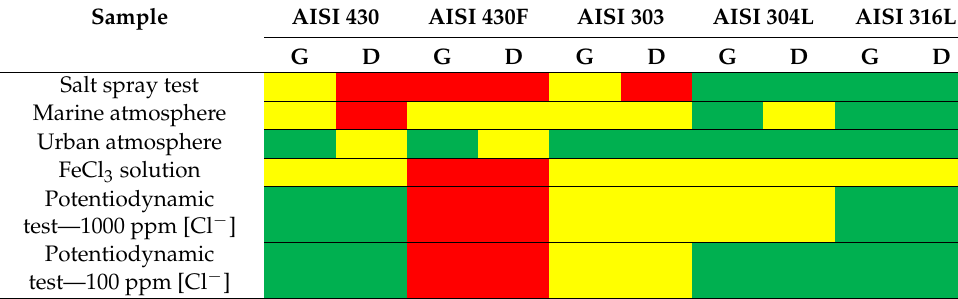
Table 9. Localized corrosion resistance results: G = ground and D = drawn.